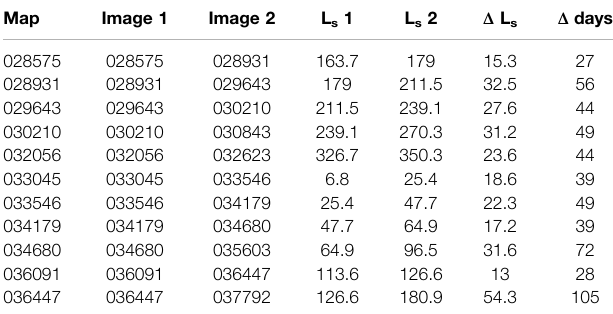
TABLE 1 | HiRISE images used to generate ripple migration maps via COSI-Corr analysis. Solar Longitudes (Ls) are given for each image to express both the timedifferencebetweenimages andtheseasonrepresentedbyeach timestep. All images are of the format